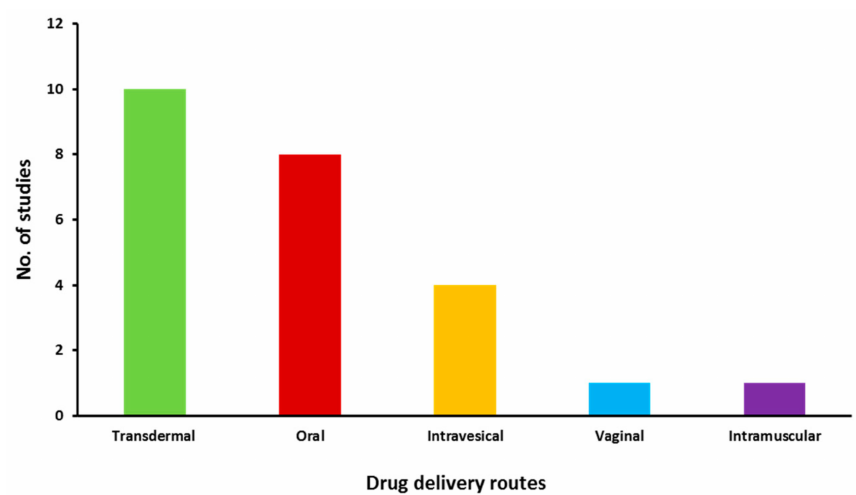
Figure 3. Distribution of eligible studies focused on different drug delivery routes.